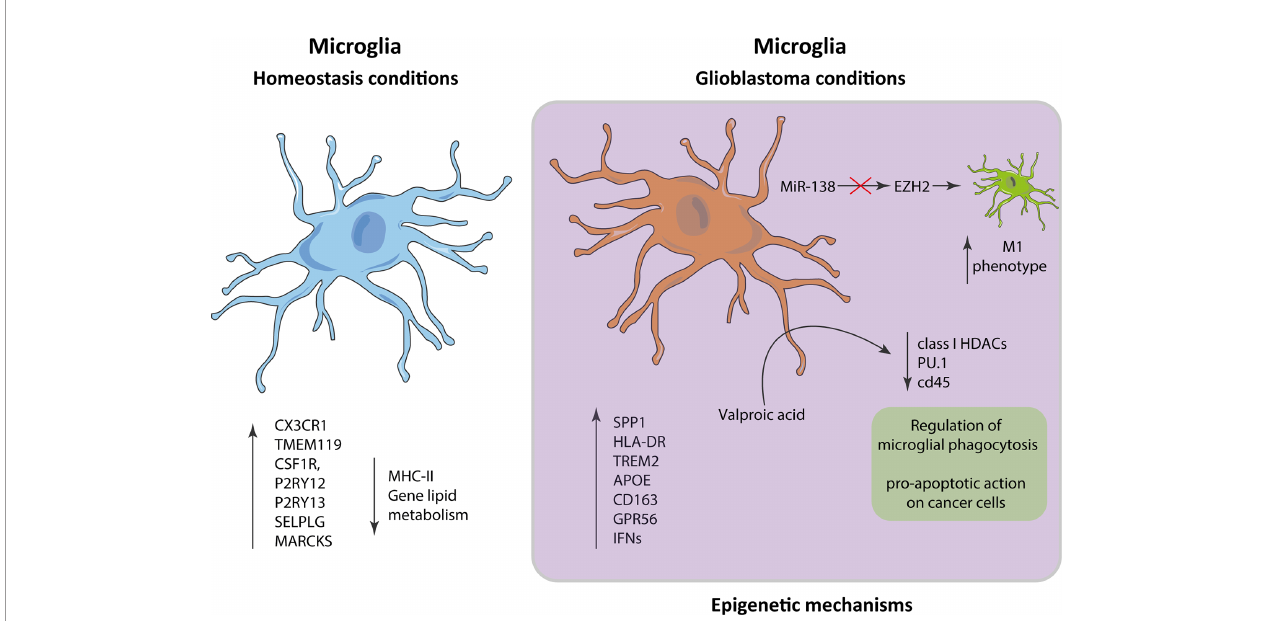
FIGURE 2 | Alterations in microglia in the context of glioblastoma. The gene expression patterns in microglia in homeostatic conditions vs glioblastoma differ signi fi cantly, presenting in the latter an in fl ammatory pattern characterized by an increase in the expression of SPP1 , HLA-DR , TREM2 , APOE , CD163 , GPR56 , and